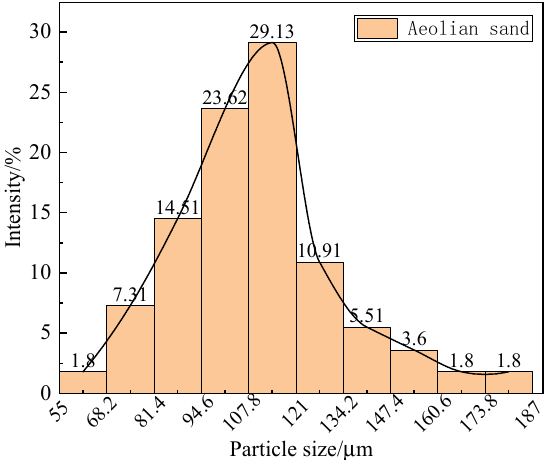
Figure 2. Particle size distribution of aeolian sand.